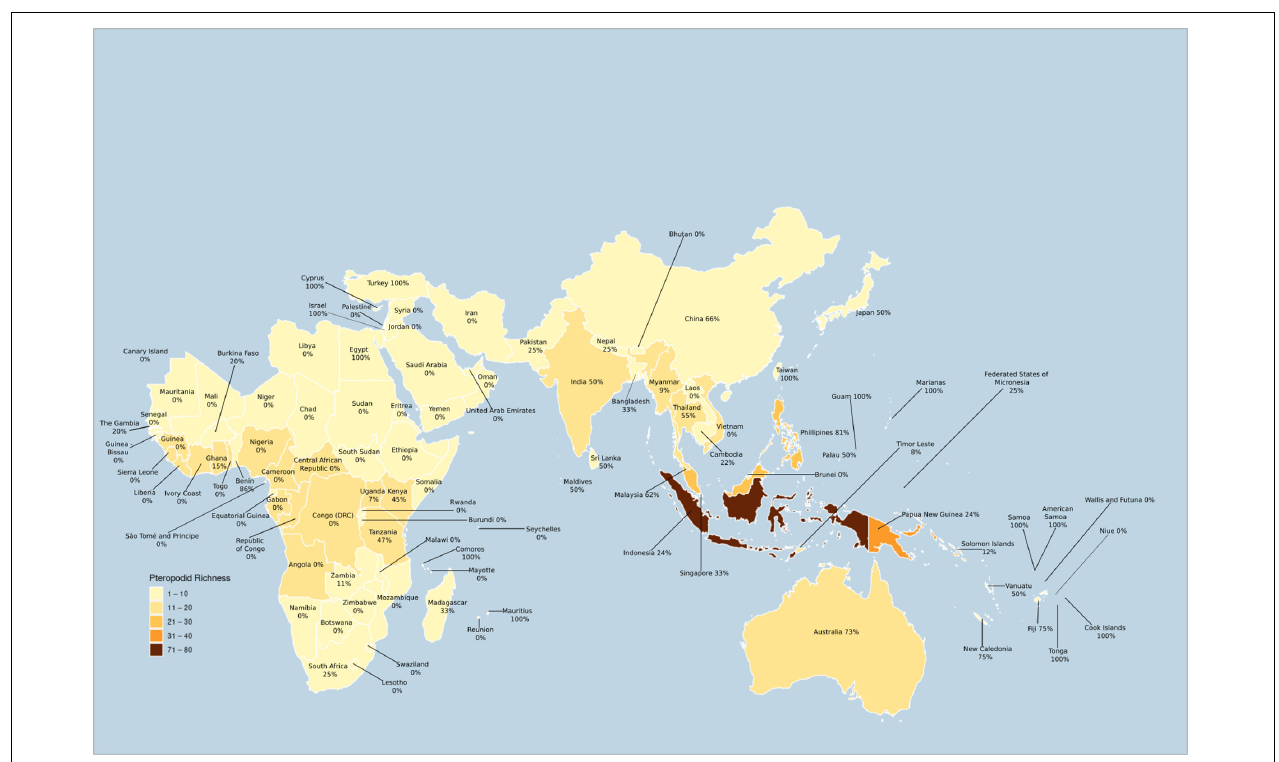
FIGURE 9 | Proportion of studied pteropodid species per country during 1985–2020 (map excludes countries with no pteropodid occurrence).